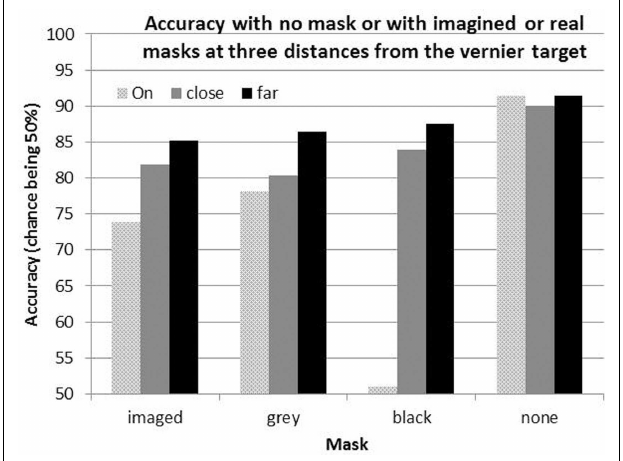
FIGURE 2 | Mean correct performance for the acuity task with imaged lines, with real gray lines matched to the participant’s images, with real black lines, and in the baseline no image, no mask (“none”) condition. The interfering lines are ON the acuity target, CLOSE to it, or FAR from it.